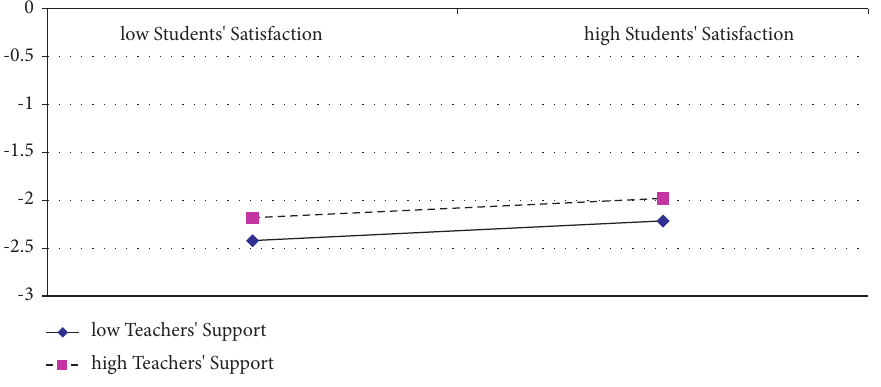
Figure 2: Interaction effect of students’ satisfaction with online learning and teachers’ academic support on the academic motivation among undergraduate students ( N �